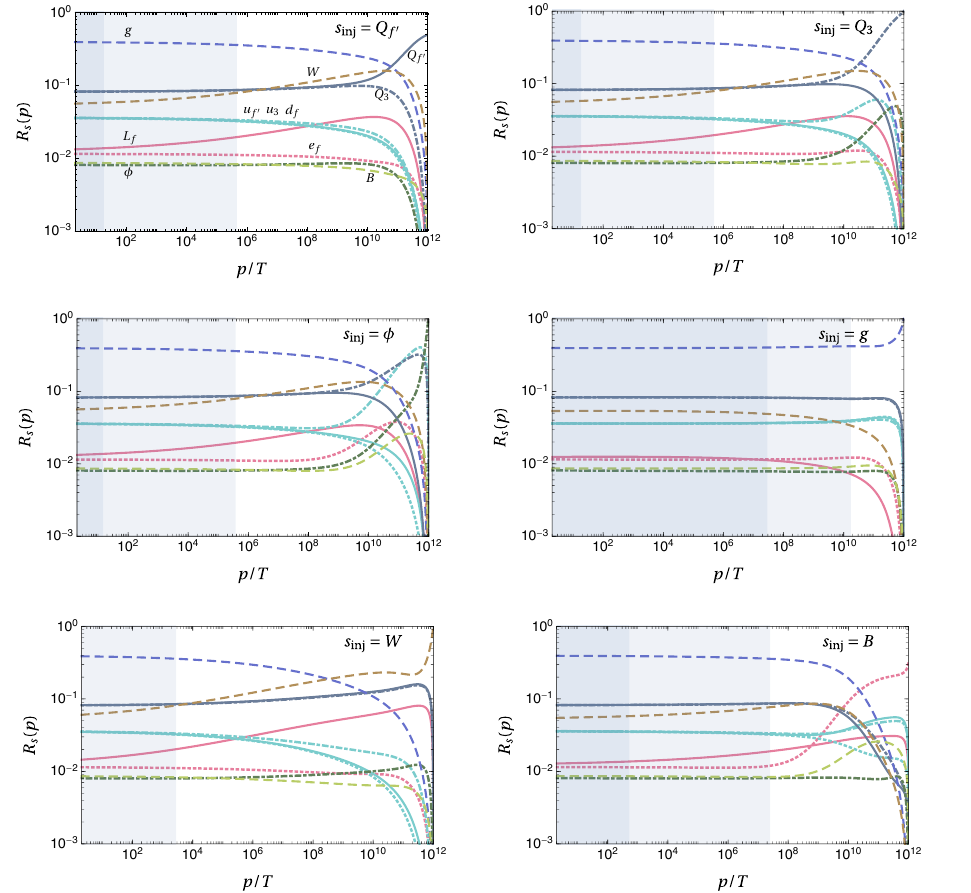
Figure 6 . Same as figure 5, but the primary particle is injected solely for Q f 0 (upper left), Q 3 (upper right), φ (middle left), g (middle right), W (lower left), and B (lower